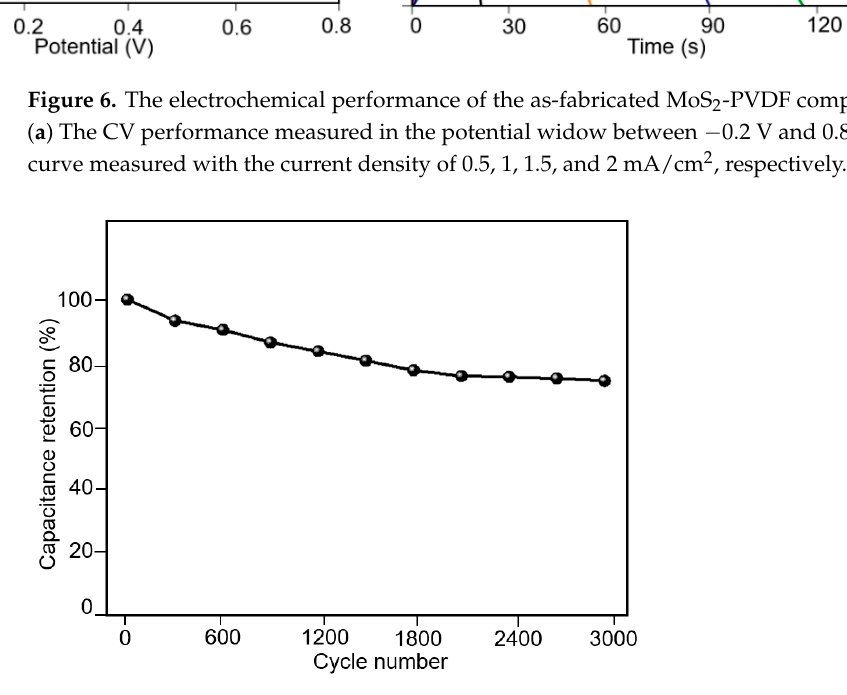
Figure 7. The electrochemical stability of the MoS 2 -PVDF composite electrodes, under the scanning rate of 50